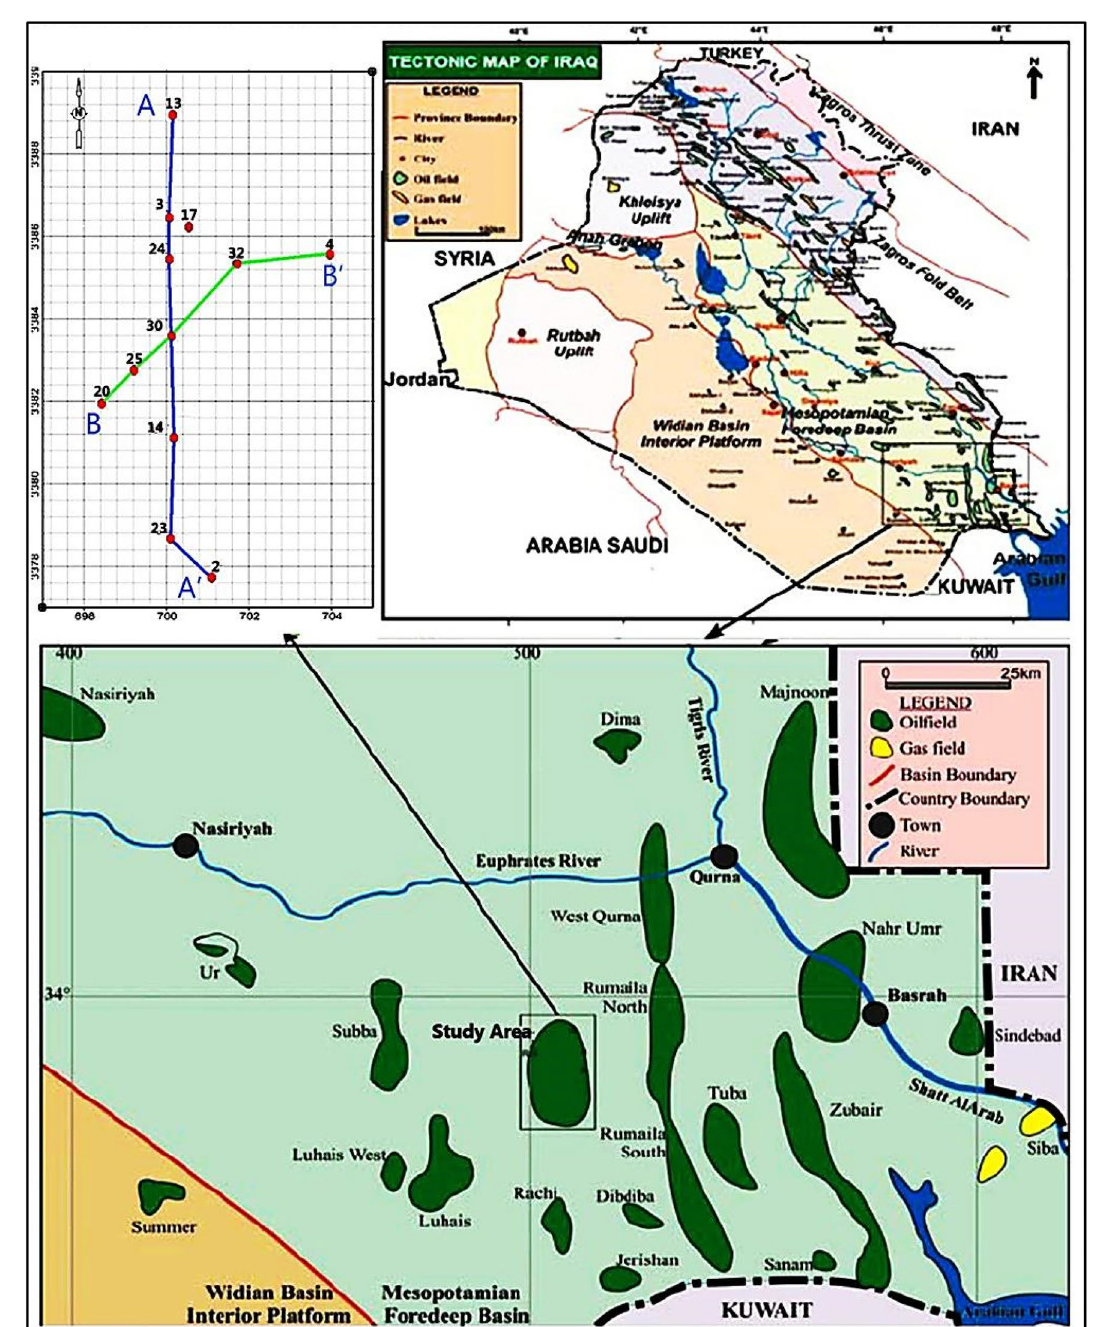
Fig. 1 Location map of the studied SWM Oil Field indicating a main oil fields in south Iraq, b the tectonic map of Iraq, and c the location map of the studied wells in the Albian sequence and the studied A–A' and B–B'